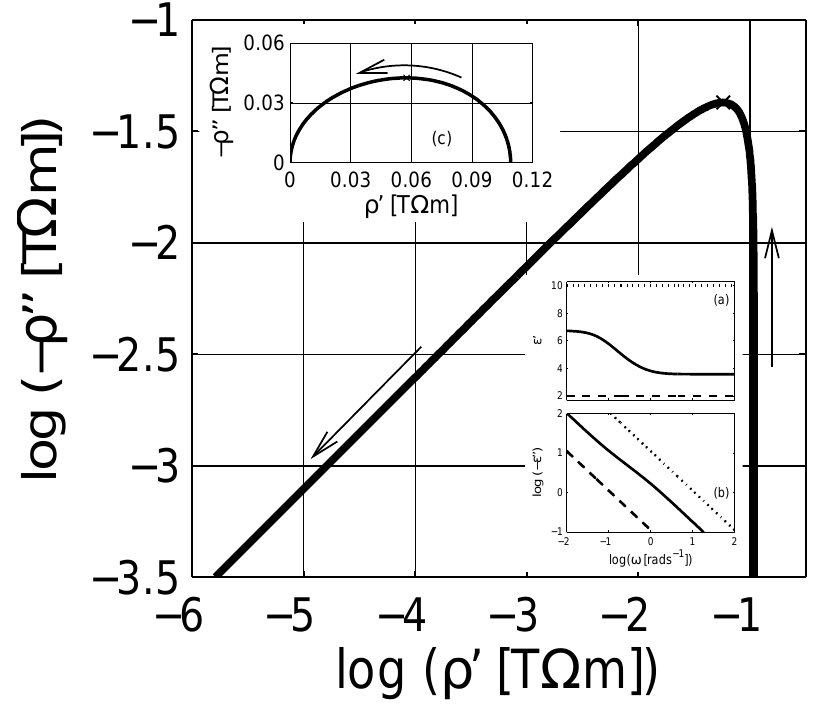
Figure 6 . The Argand diagram of resistivity for a Landau-Lifshitz/Looyenga composite in = ε LLL ( ω ; ε , ε , 0 . 3 , 3) , with log-log scale; the effective permittivity is calculated by ε e m i e ε = 2 + 10 − 12 ( ıε ω ) − 1 and ε = 10 + 10 − 10 ( ıε ω ) − 1 . The arrows indicate the direction m 0 i 0 of increasing angular frequency ω . Insets (a) and (b) are the real and the imaginary parts of permittivities; ε , ε and ε are the permittivities for the matrix (– – –), inclusion (- - - - -) e m i and effective (——–) media. Inset (c) is the Argand diagram of resistivity in linear-linear scale. Logarithmic scale is base